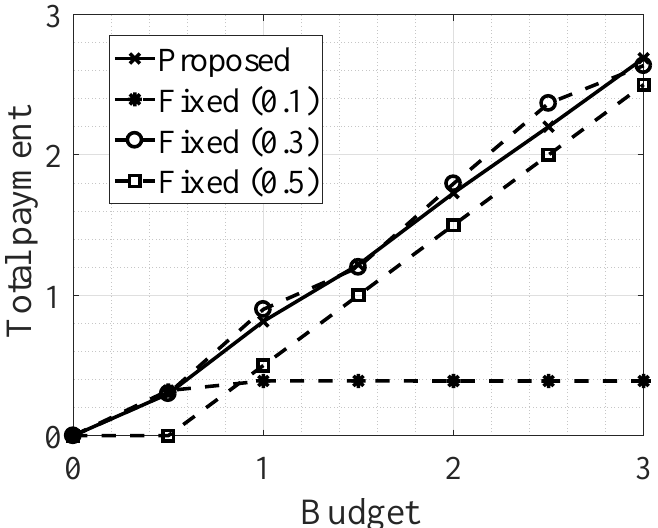
Figure 3. Total payment vs. monetary budget.